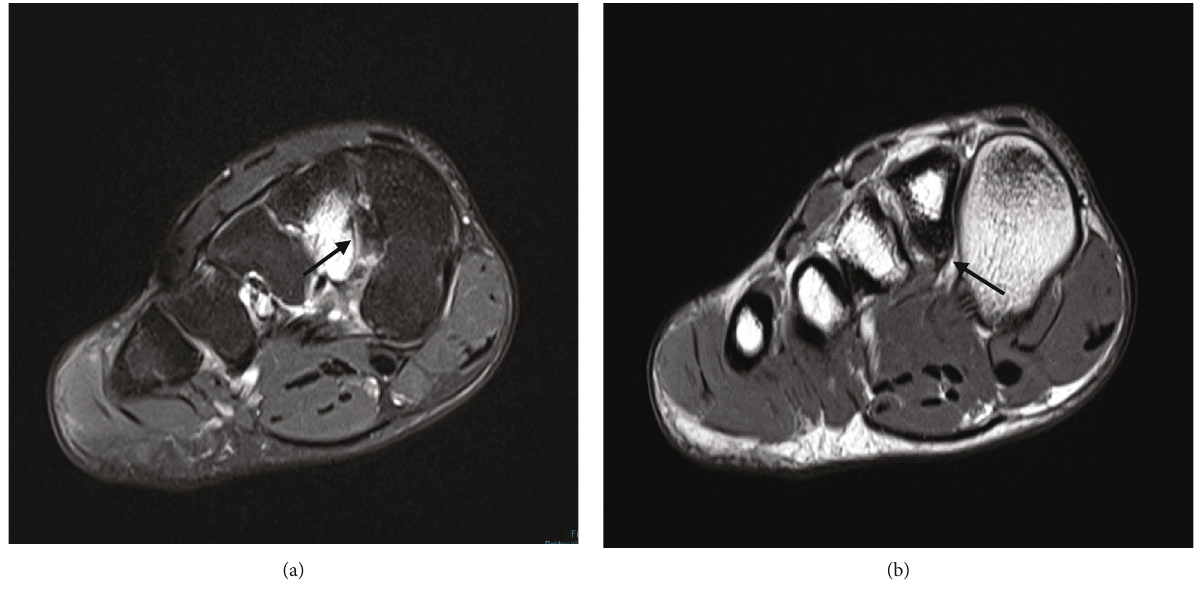
Figure 2: (a, b) An 18-year-old footballer with second metatarsal tenderness worse on running and jumping. Axial PDFS (a) shows localized marrow oedema signal at the plantar margin of the base of the second metatarsal involving both interosseous (arrow) and plantar Lisfranc footprints (dash). Minor Lisfranc proper periligamentous oedema without a discrete tear or elongation identi fi ed, consistent with grade I sprain. Axial PD (b) clearly demonstrates the cortical thickening at the second metatarsal base (arrow).